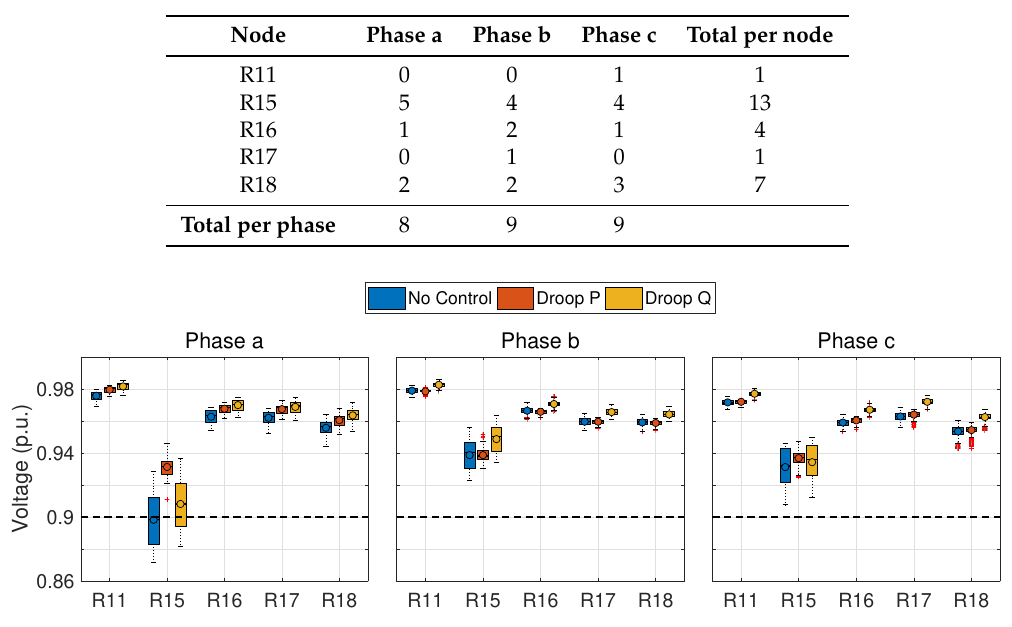
Table 4. Number and phase of EVs connected per node for Scenarios I, II, and III.